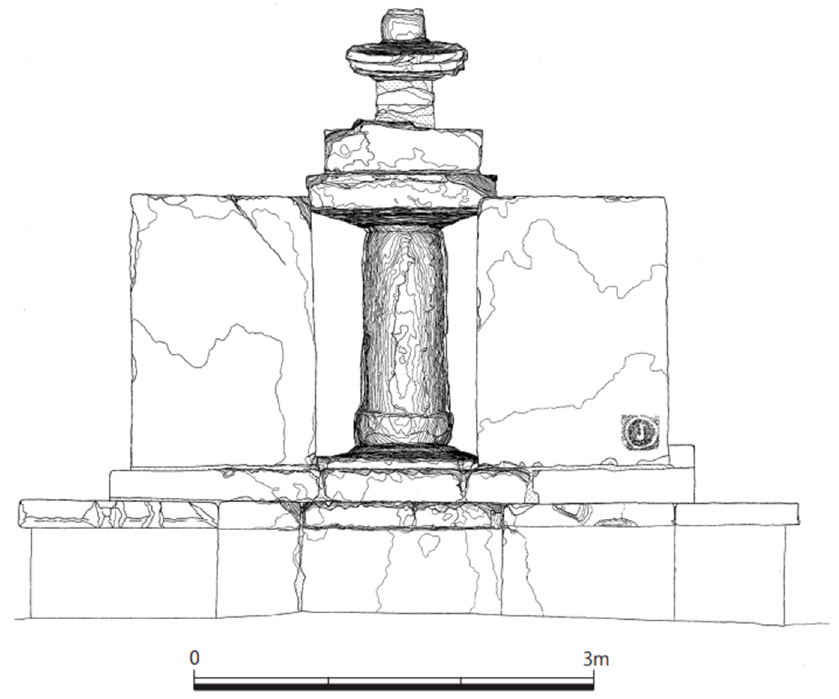
Figure 3. Drawing of Okamasu Ishind ō (based on (Kasano et al. 1999), with modifications by the author).